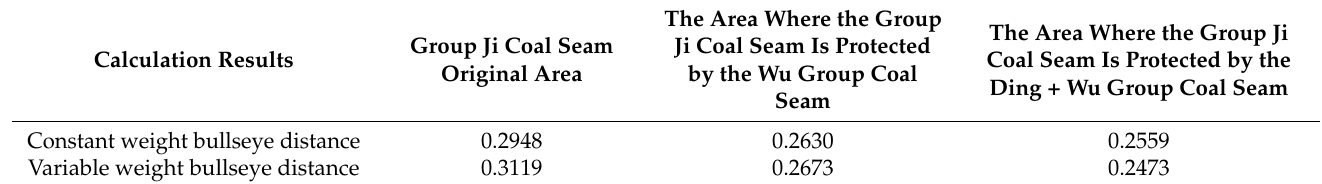
Table 9. Comparison of variable weight and constant weight projection bullseye distance for the group Ji protection